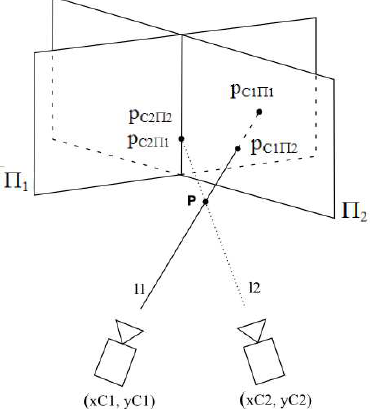
Figure 7. Reconstruction of coordinates for points which are seen by one of the cameras close to the intersection line of control planes. Line l be calculated.